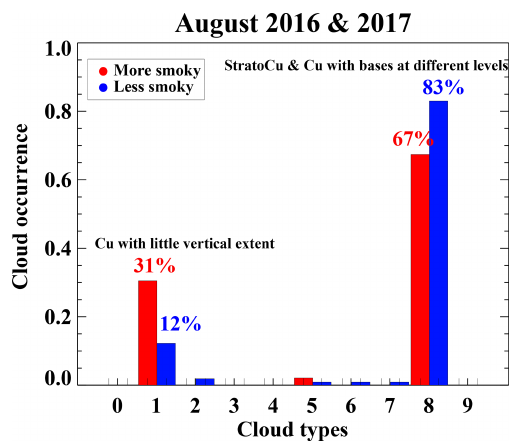
Figure 10. Frequency of occurrence of each WMO-defined surface- observed cloud type composited by “more” (red) and “less” (blue) smoky